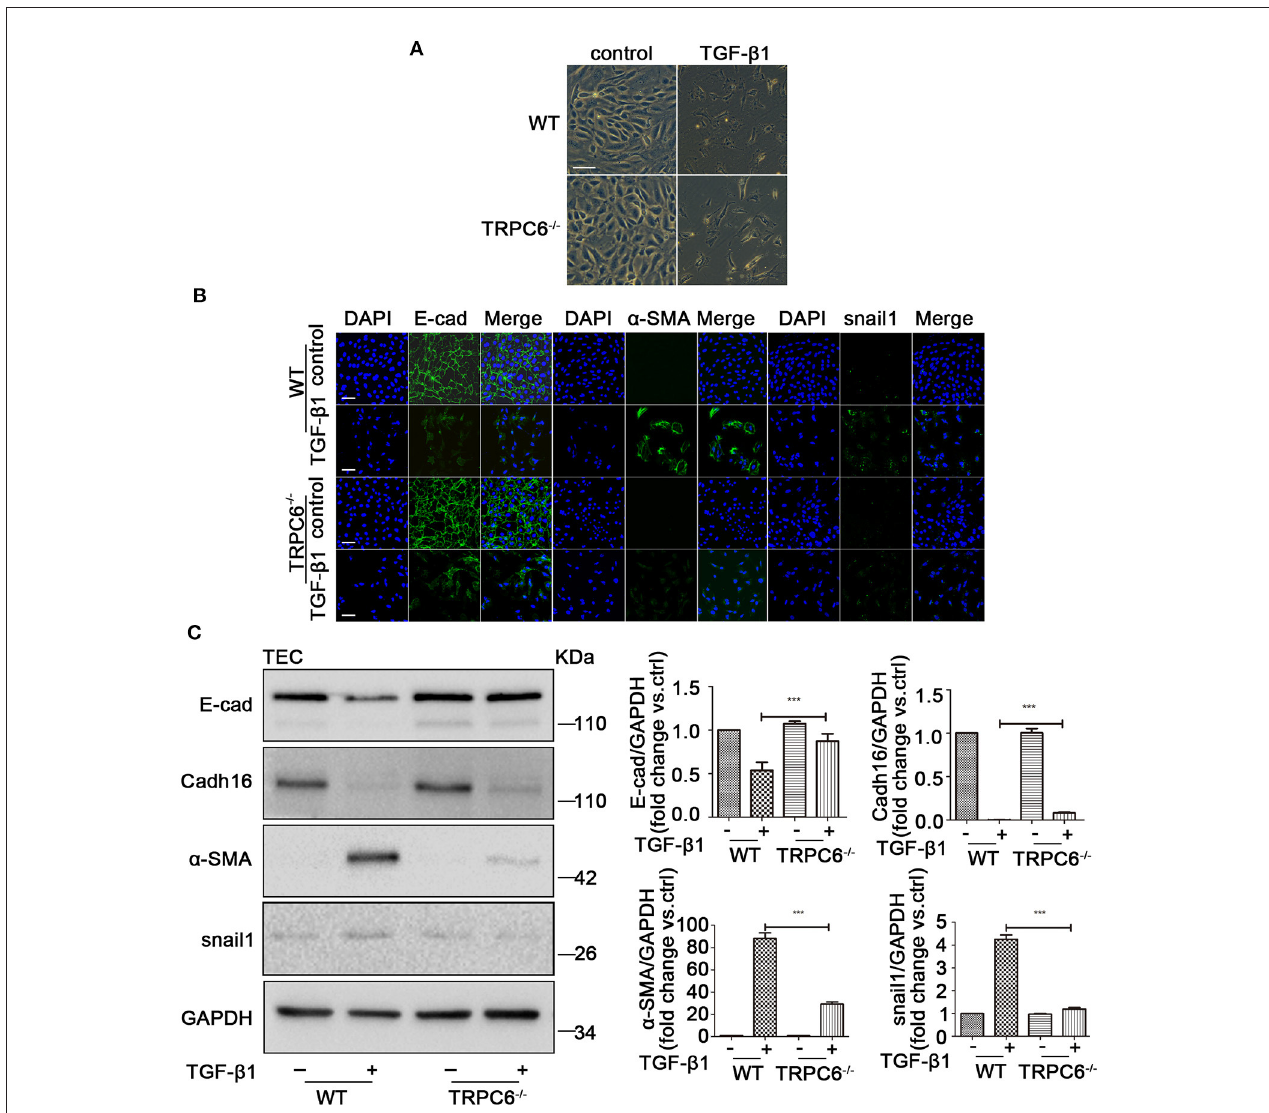
FIGURE 4 | The process of EMT was inhibited in primary TEC stimulated with TGF- β 1 inTRPC6 − / − mice. (A) Morphological changes of primary TEC from WT and TRPC6 − / − mice with and without TGF- β 1 stimulation for 72h. (B) Expression level of EMT markers (green) E-cad, α -SMA, and snail1 as well as nuclear stain DAPI (blue) from the above groups detected by immunofluorescence analysis. Scale bars, 20 µ m. (C) Expression level of EMT markers E-cad, Cadh16, α -SMA, and snail1 from the above groups detected by western blot. Data are presented as mean ± sem, n = 3; an unpaired two-tailed t -test was used. *** P <